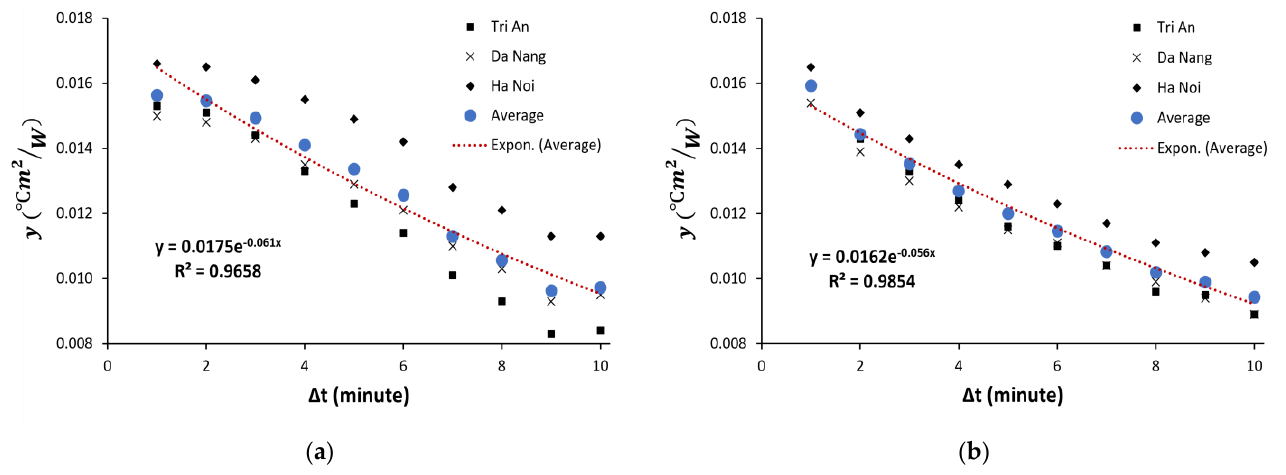
∆𝑇 𝑟𝑒𝑓 ∆ T 𝑓(∆𝑡) in different time steps from Table 4 and exponential fitting curve for the Figure 1. Plot of the values of 𝑦 = ref f ( ∆ t ) in different time steps from Table 4 and exponential fitting curve for the mean Figure 1. Plot of the values of y = 𝐺 0 G 0 mean value 𝒚̅ . ( a ) Model with wind speed. ( b ) Model without wind speed. value y . ( a ) Model with wind speed. ( b ) Model without wind speed.